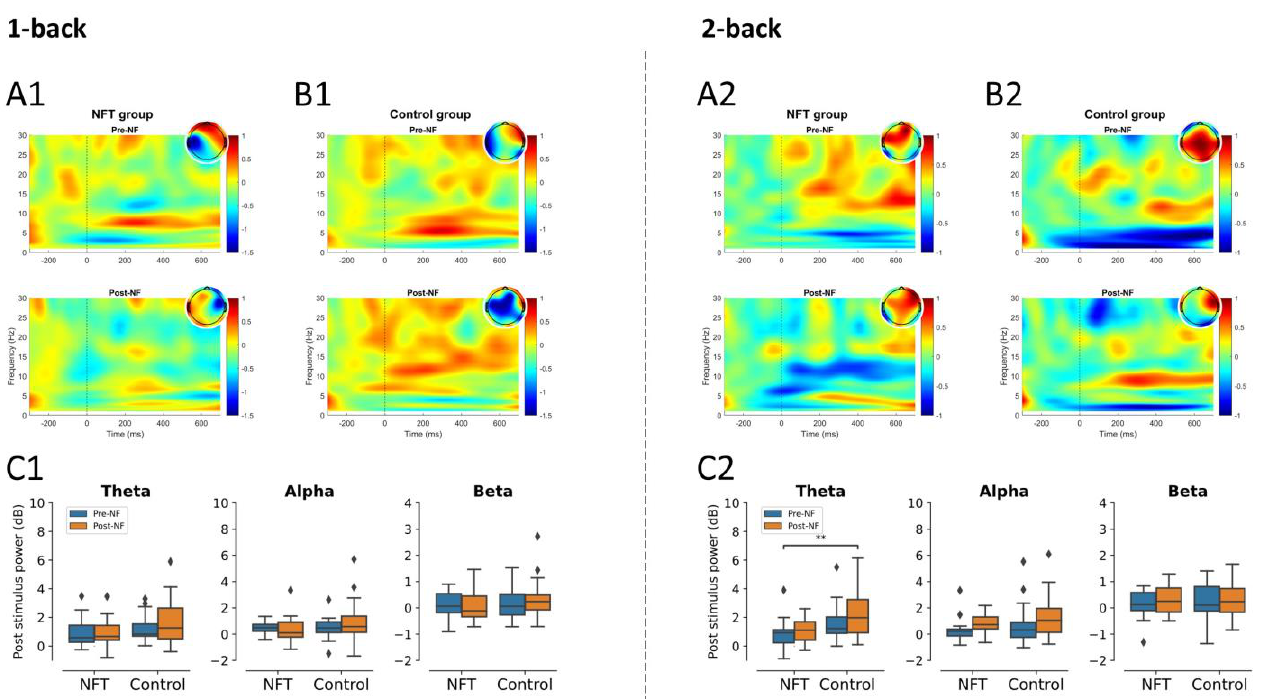
Figure 5. Post-stimulus power in frontal lobe (** p < 0.005): 1-back post-stimulus power in ( A1 ) NFT group and ( B1 ) control group; 2-back post-stimulus power in ( A2 ) NFT group and ( B2 ) control group. Post-stimulus power in different EEG bands within each group in ( C1 ) 1-back and ( C2 ) 2-back conditions. The colour bar of the TF plots represents the value of EEG power in dB scale. The diamond shape in the box plots represents the outliers in the data.